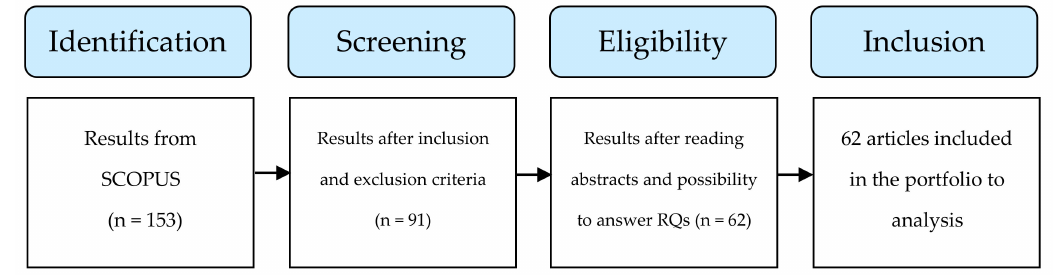
Figure 1. Obtaining the articles for review.